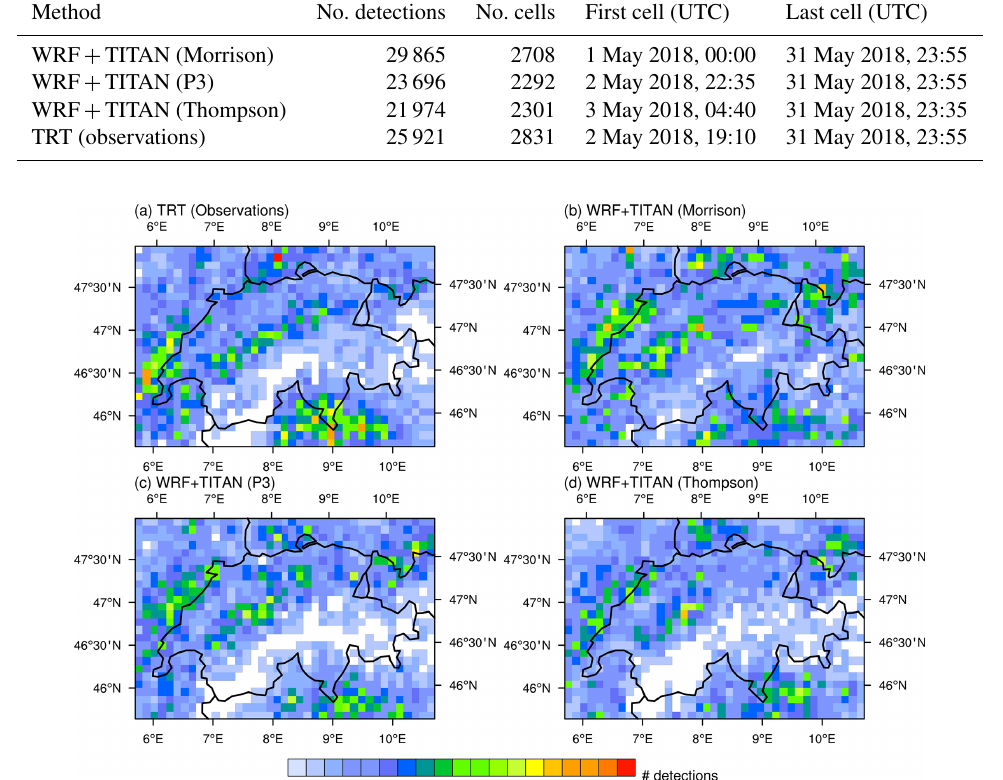
Figure 5. The overall number of cell detections (cell–time combinations) in each 10 × 10km 2 grid point, for May 2018, for observations (a) and simulations with three different microphysics schemes (b–d) . Plot produced using NCL version